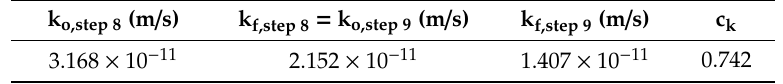
Table 8. Second application. c k and initial and final hydraulic conductivities for loading steps 8 and 9.